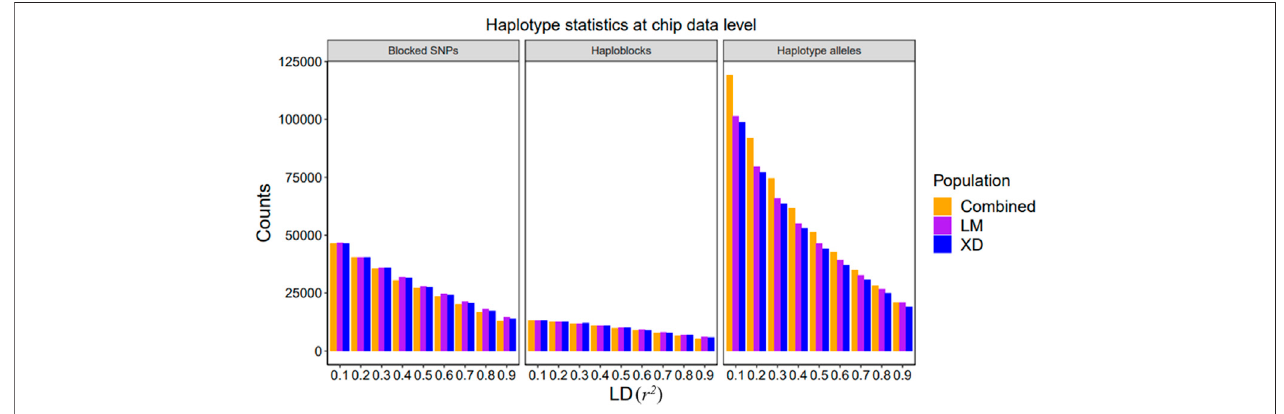
FIGURE 2 | Summary of single and combined population haplotype statistics at the chip data level. The bar plot of the counts of blocked SNPs, haploblocks, and haplotype alleles in different LD threshold value, respectively.